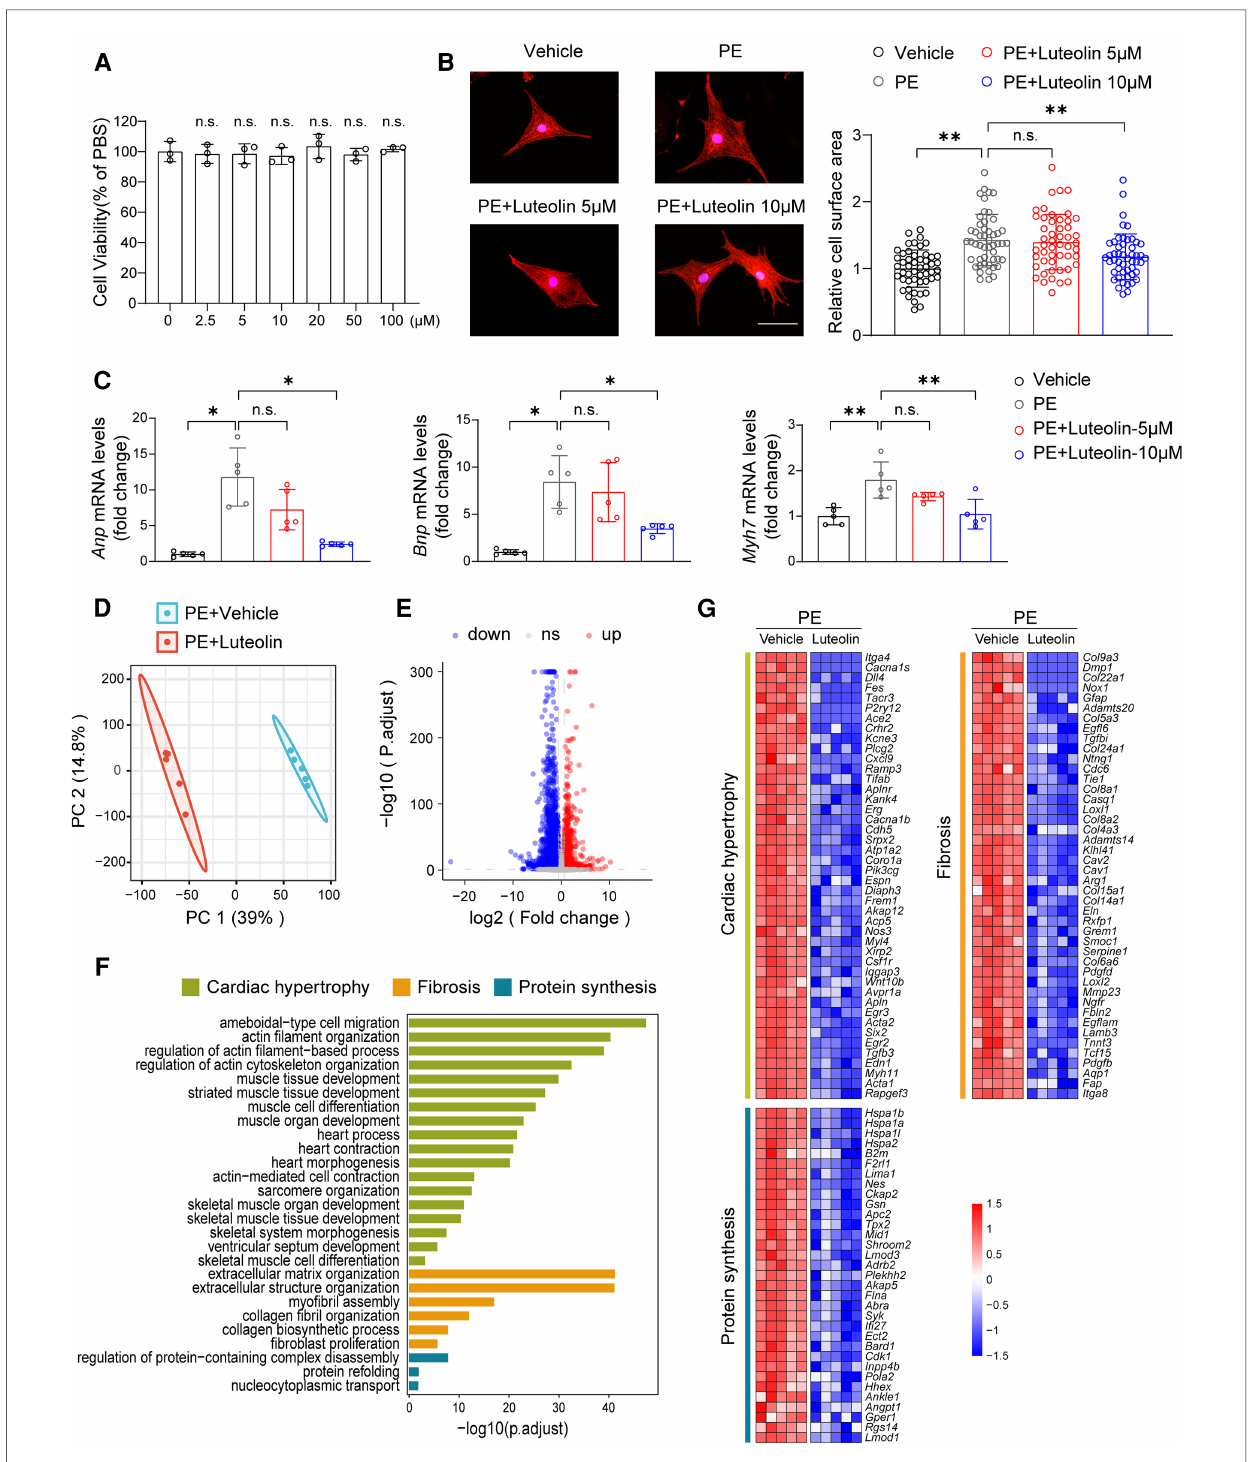
FIGURE 2 Luteolin ameliorates PE-induced cardiomyocyte hypertrophy in primary cardiomyocytes. ( A ) Relative cell viability of NRCMs after treatment with different concentrations of luteolin. The data shown are representative of three independent experiments. n.s., no signi fi cant difference compared to the 0 μ M group. ( B ) Representative immuno fl uorescence images (left) of α -actinin staining and quantitative results of the cell surface area (right) of NRCMs treated with PBS, PE (50 μ M), or PE+luteolin (5 or 10 μ M) for 24 h ( n ≥ 50 cells per group). Scale bar, 50 μ m. The data shown are representative of three independent experiments. ( C ) Relative mRNA levels of cardiac hypertrophy marker genes ( Anp , Bnp , and Myh7 ) in NRCMs treated with PBS, PE (50 μ M), or PE+luteolin (5 or 10 μ M) for 24 h ( n =5 independent experiments). ( D ) Principal component analysis showing the global sample distribution pro fi les between groups based on the RNA-sequencing data. ( E ) Volcano plot analysis showing a huge number of differentially expressed genes between the two groups. Genes with adjusted P -values less than 0.05 and a fold change larger than 1.5 was recognized as differentially expressed genes. ( F ) Gene set enrichment analysis of molecular events involved in cardiac hypertrophy, fi brosis, and protein synthesis in RNA-sequencing data. ( G ) Heatmap showing the signi fi cantly altered genes related to cardiac hypertrophy. Values are presented as mean±SD. * P <0.05, ** P <0.01, n.s., no signi fi cant difference. PE, phenylephrine; Anp , atrial natriuretic peptide; Bnp , b-type natriuretic peptide; Myh7, myosin heavy chain